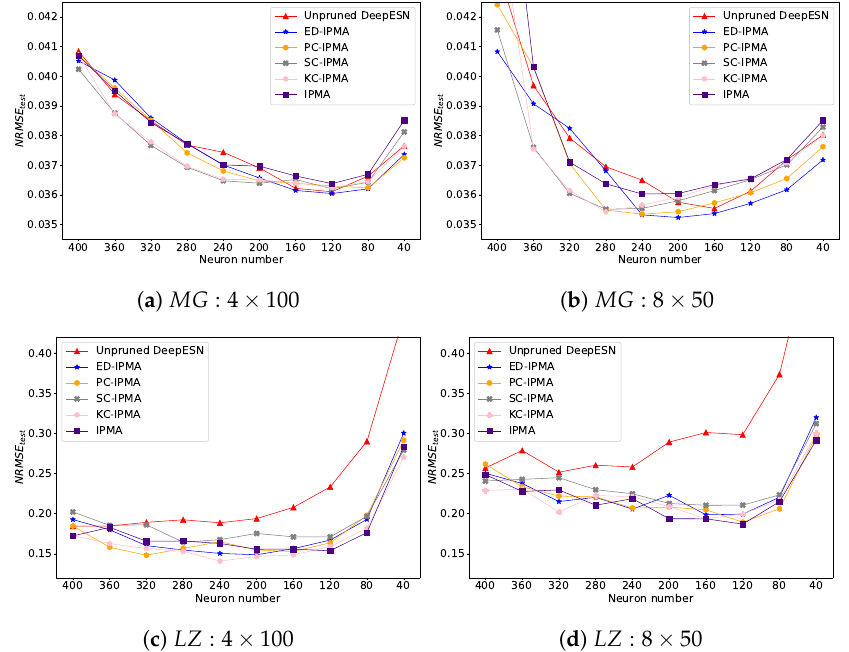
Figure 10. Testing NRMSE comparison of unpruned DeepESN and DeepESN pruned by IPMA, ED-IPMA, PC-IPMA, SC-IPMA, KC-IPMA. ( a ): Initial 4 layer reservoirs with 100 neurons in each reservoir on MG dataset; ( b ): Initial 8 layer reservoirs with 50 neurons in each reservoir on MG dataset; ( c ): Initial 4 layer reservoirs with 100 neurons in each reservoir on LZ dataset; ( d ): Initial 8 layer reservoirs with 50 neurons in each reservoir on LZ